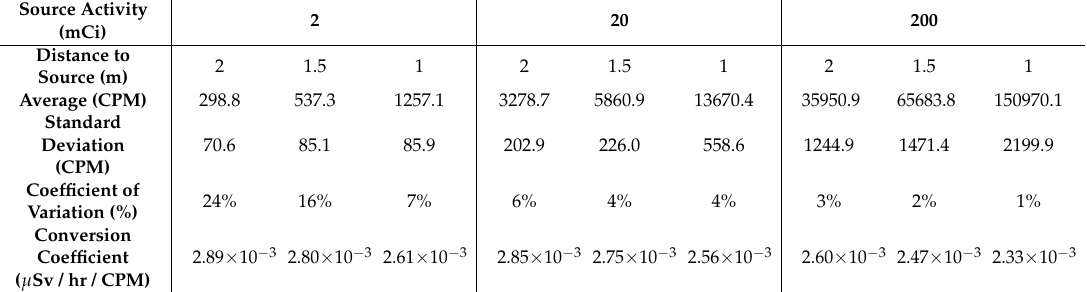
Table 7. Average value, standard deviation, coefficient of variation, and conversion coefficient of each acquired set of 20 values for the Mazur, considering each source-distance configuration. Background acquisition had an average value of 44.8 CPM and a standard deviation of 23.8